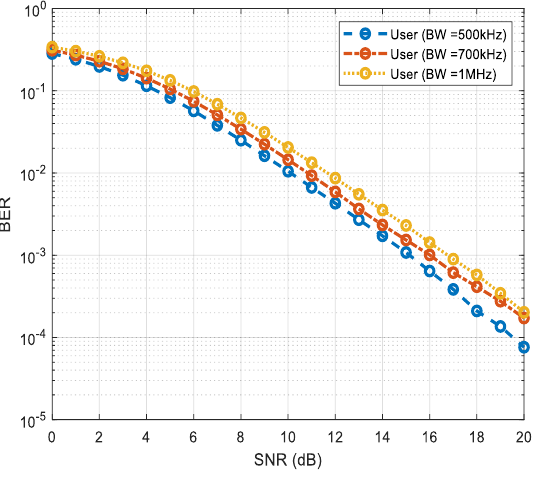
Figure 8. BER against SNR for one user with the different BW This scenario studies the performance of a single user at the fixed distance of (950m), power coefficient of (0.75) and for different BW of (500, 700, 1000) KHz.